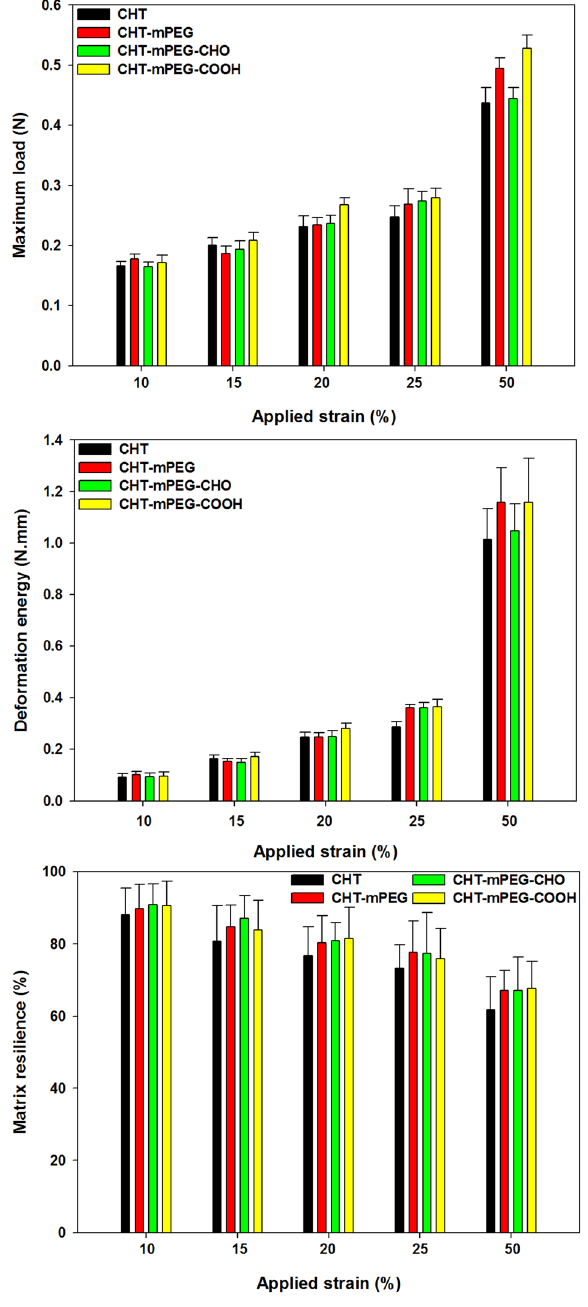
Figure 7. Physicomechanical properties of various CHT/mPEG cryosponge formulations under partial applied strain values of 10–50% (data represent mean ± std. dev. from 3 independent